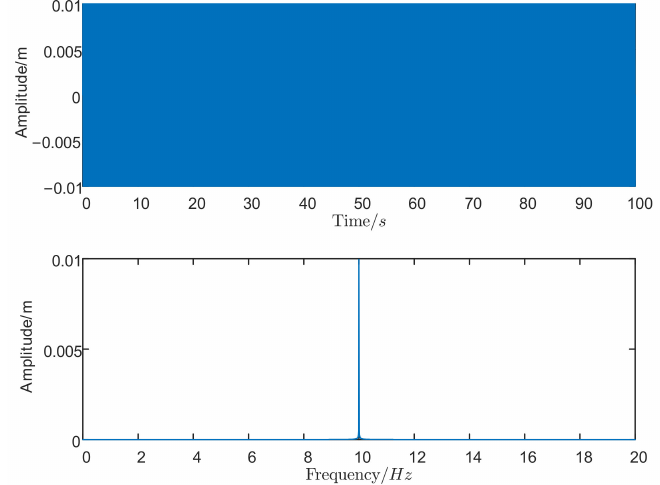
Figure 18. Time histories and FFT result of displacement excitation at f = 10